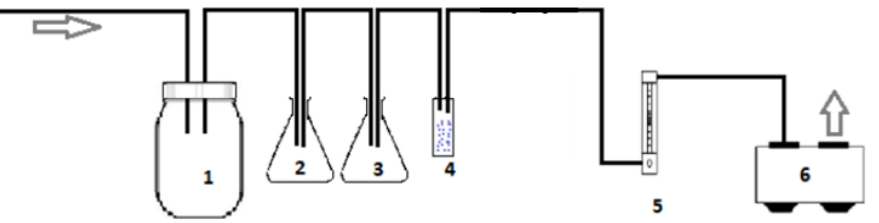
Figure 1. Schematic diagram of the version used to measure ammonia emissions: 1. The reactor; 2. Acid trap; 3. Water; 4. Desiccant; 5. Flowmeter; 6. Suction pump (adapted from [11]).